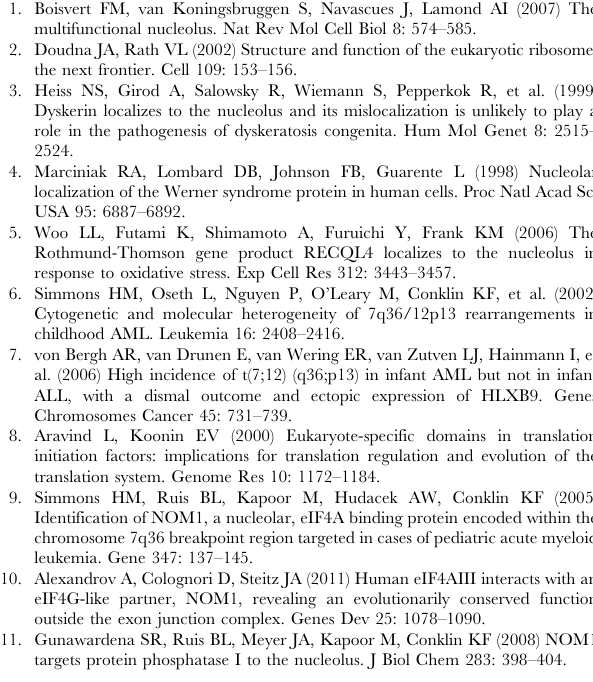
top. (A, D) In morphant group, the GFP labeled exocrine pancreas size is the same as WT. (B, C, E, F) The exocrine pancreas began to enlarge in WT larvae, but not for the nom1 -knockdown embryos at 2.5 dpf and 3 dpf. Table S1, Differentially expressed genes in dg5 versus sibilings at 2.5 dpf. Table S2, GO enrichment analysis in dg5 mutant. Table S3, Isoforms analysis in dg5